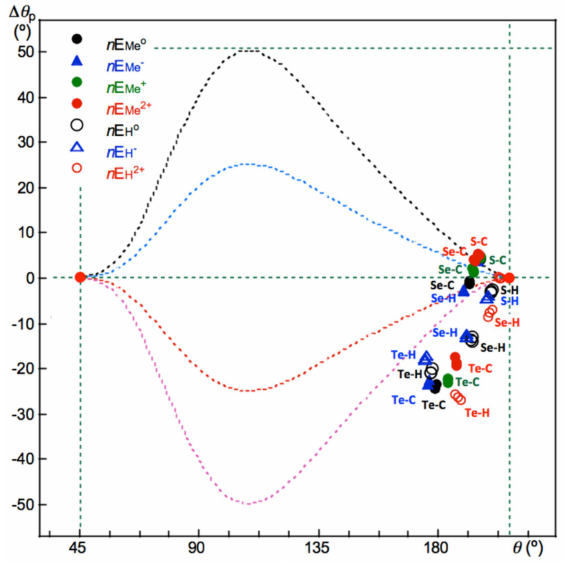
Figure 7. Plots of ∆ θ p versus θ for E- ∗ -C, E’- ∗ -C, E- ∗ -H and E’- ∗ -H in [REE’R]* (R = Me and H: * = null, − , +, and 2+), calculated with MP2/BSS-C. See Table S8 of the Supplementary Materials for the data. Red circles correspond to the θ period of 45.0 ◦ ≤ θ ≤ 206.6 ◦ and green horizontal lines are for ∆ θ p = 0 ◦ and 50.0 ◦